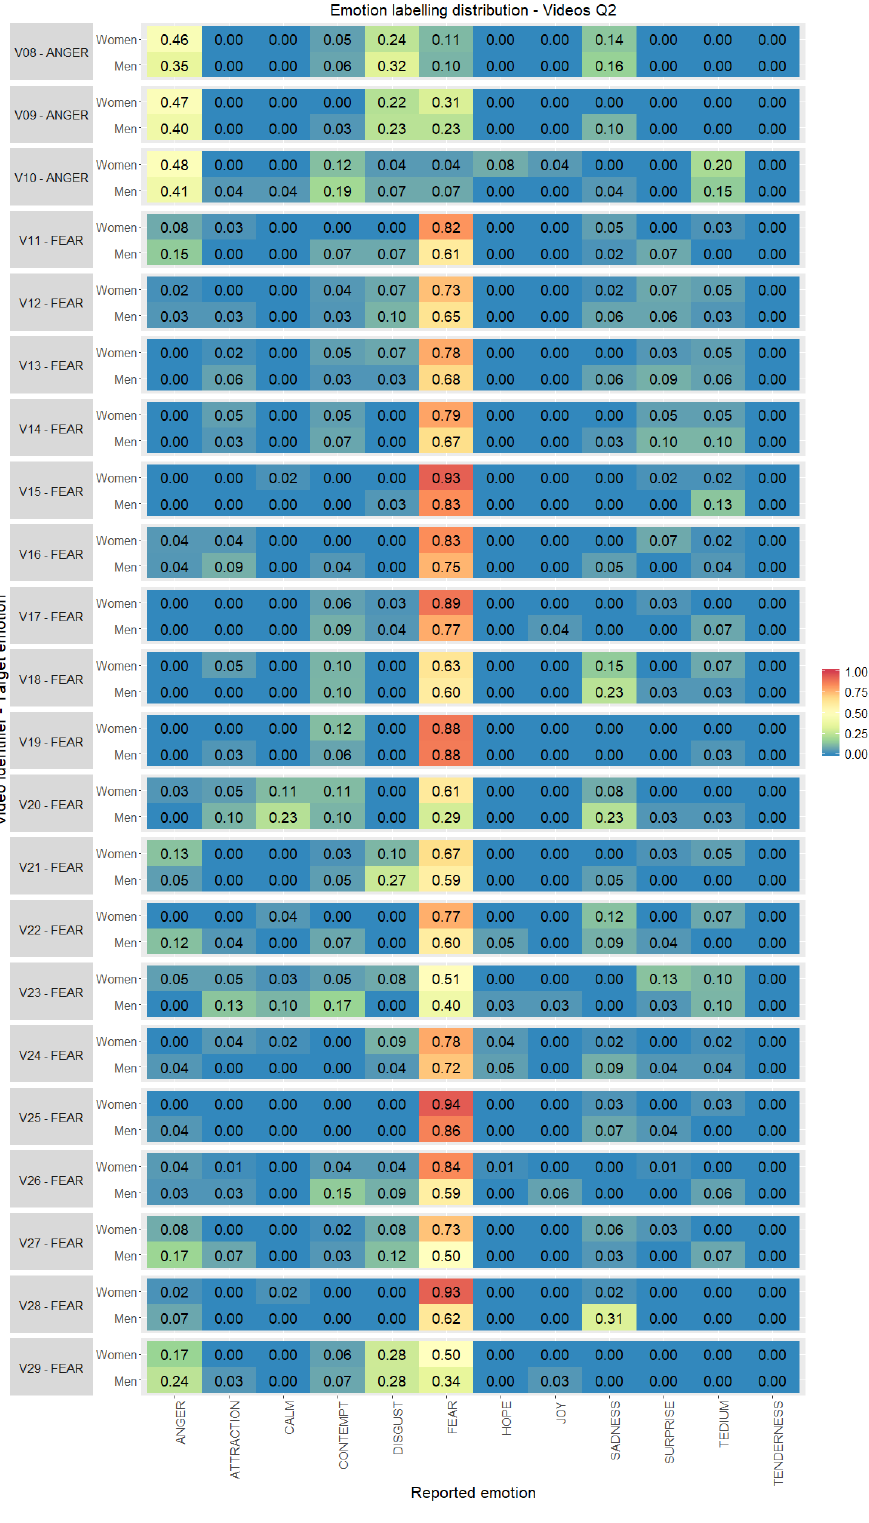
Figure 5. Emotion labelling distribution (0.00–1.00) between the emotions reported by the volunteers with respect to the original target per video clip selected, gender and quadrant 2 (percentage computed considering individually women and men totals per stimuli).